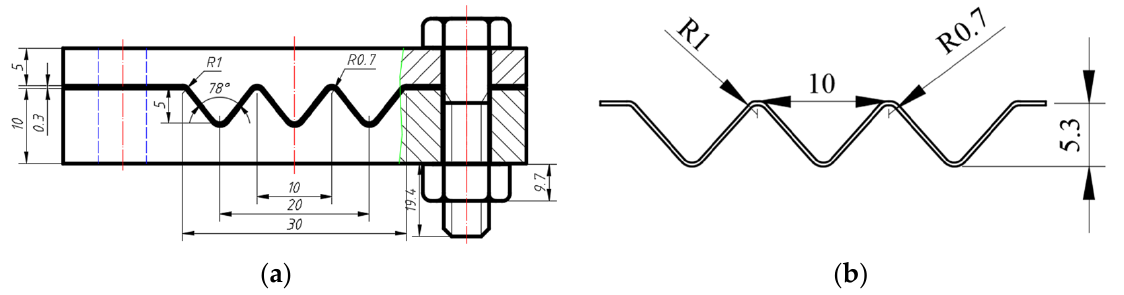
Figure 3. Geometries of corrugated sample and its processing fixture: ( a ) Geometry of the mould; ( b ) Geometry of corrugated specimens. Table 1. Chemical composition of NiTi alloy plate (wt.%)